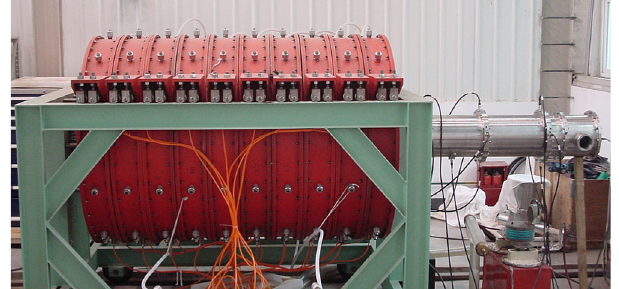
FIG. 4. Photo of the 10-stage LTD system, in which ten identical 100 kA LTD stages are connected in